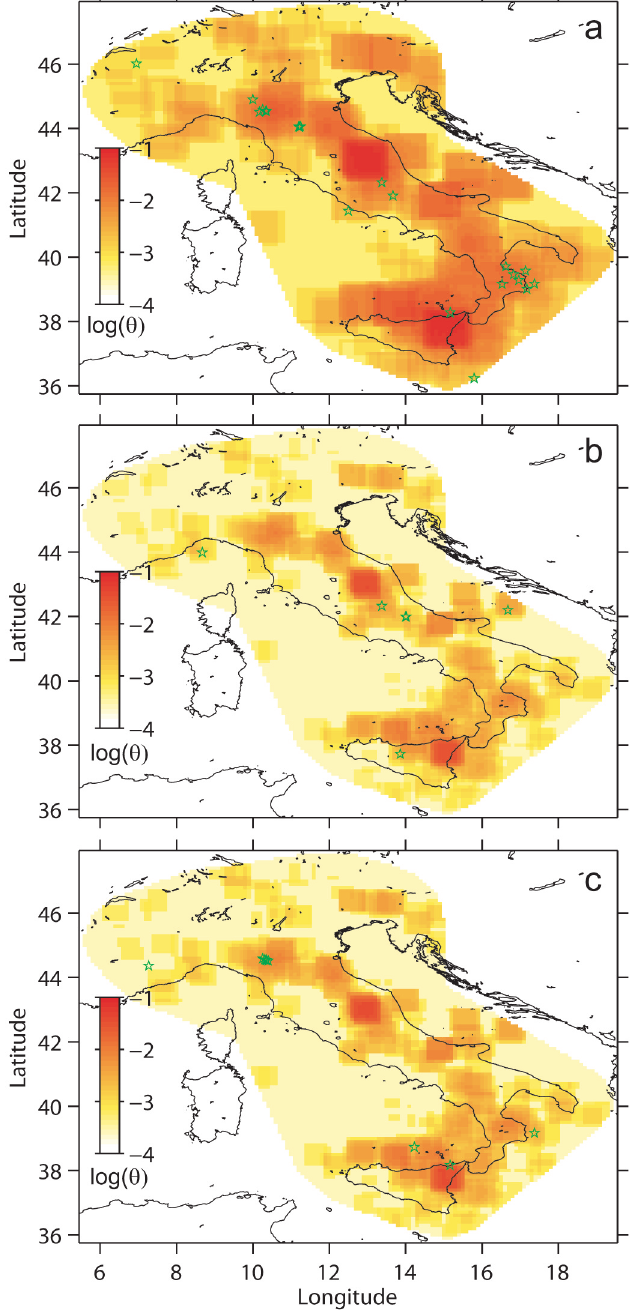
Figure 5. RI-based retrospective forecast maps. (a) Forecast period from t = 2 April 16, 2005, to t = March 31, 2009 for 4 ≤ M ≤ 9 events. The smoothing 3 parameter used was the optimal S = 5, based on the search shown in Figure ) is given in the color 4a. The logarithm of the cumulative forecast number ( i i code. The targets (stars) show 31 4 ≤ M ≤ 9 events that occurred during the forecast period. (b, c) Forecast periods from t = January 1, 2009, to t = March 2 3 = October 1, 2008, to t = December 31, 2008 (c) 31, 2009 (b), and from t 2 3 for 3.5 ≤ M ≤ 9 earthquakes. Smoothing parameter used both was the appropriate value ( S = 3) based on the search in Figure 4b. Stars indicate the 6 and 9 target earthquakes that occurred in the forecast periods,